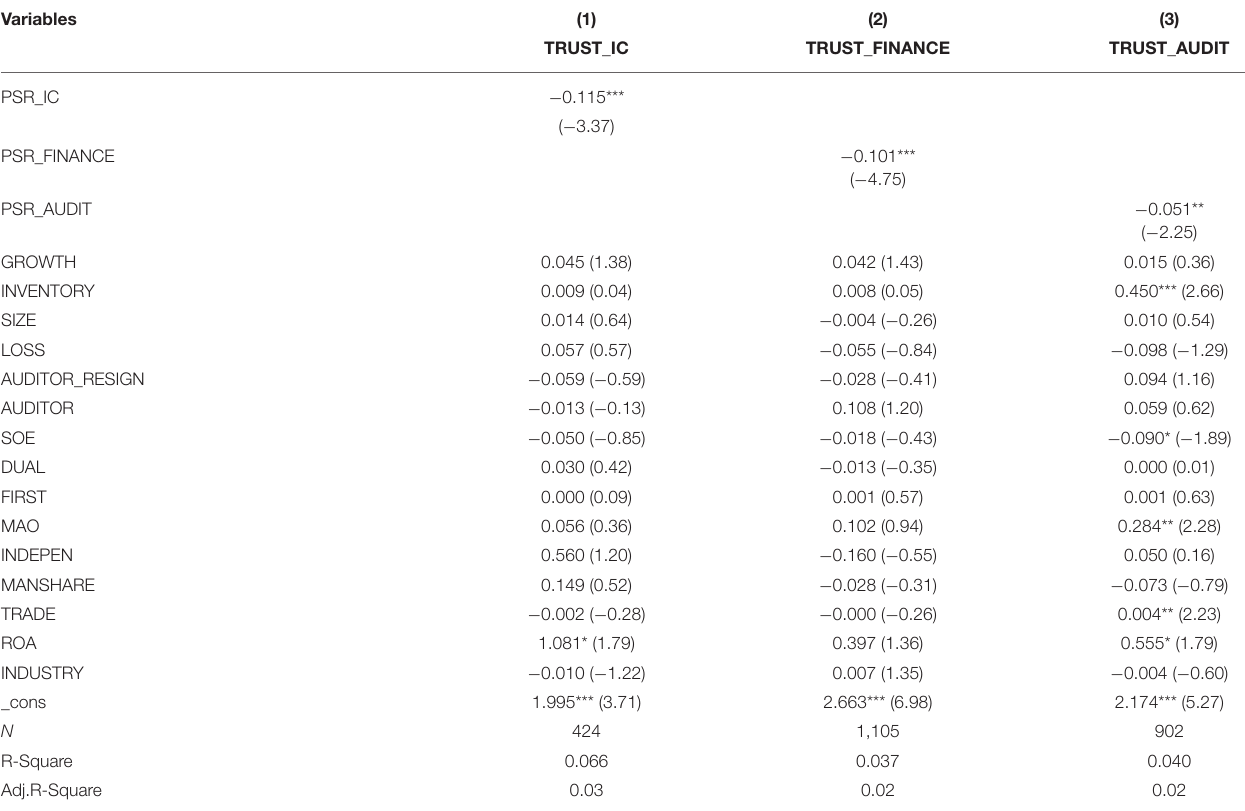
TABLE 8 | PSR and organizational